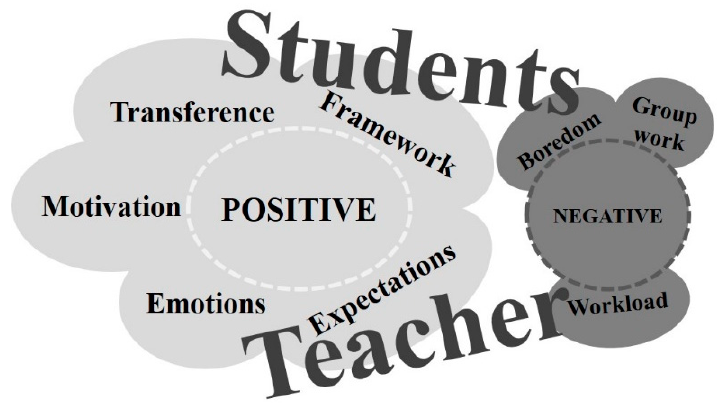
Figure 3. Results of the thematic content analysis.